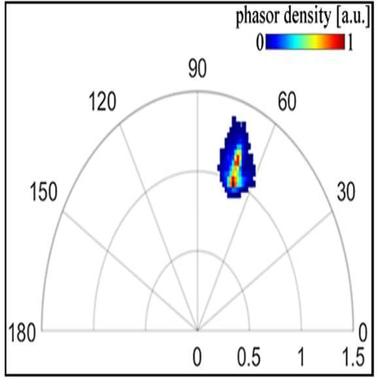
Phasor distribution density diagram computed based on s-SNOM amplitude and phase images collected on an ultra-thin section of a zebrafish retina. Two main peaks visible in the diagram suggests that at least two types of cells can be associated with different phasors.